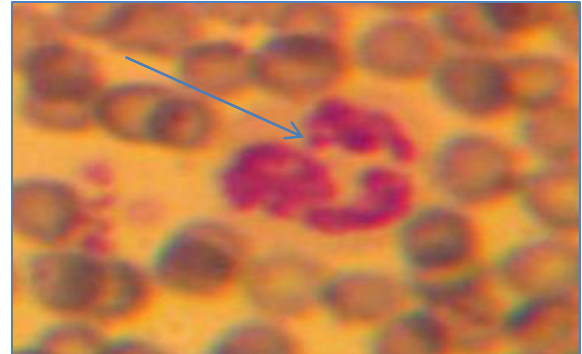
Figure, 1: Drum stick (1000x).